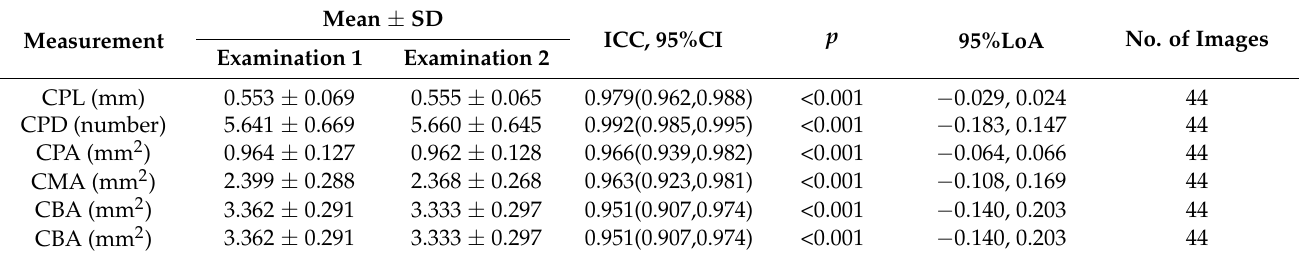
Table 2. ICC and 95% LoA results for ciliary body anatomy measured in the superior quadrant from the transverse scan.